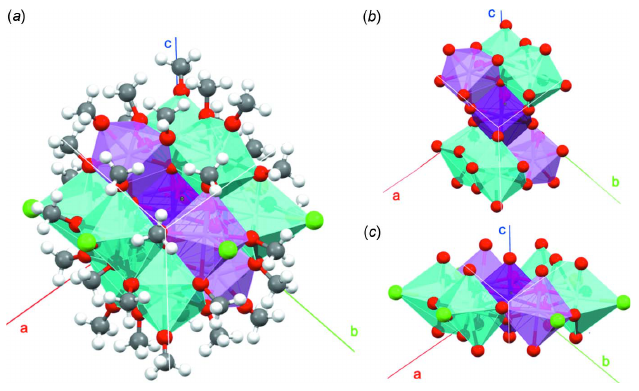
Figure 2 Molecular structure of the {U 13 } cluster I . Uranium atoms are illustrated with coloured polyhedra. The structure is drawn as [U 13 ( (cid:2) 4 -O oxo ) 8 - Cl 6 (MeO) 32 ] in order to omit the disorder between chloride and methoxide anions for clarity. Colour code: hydrogen, white; carbon, black; oxygen, red; chlorine, light green. Hydrogen and carbon atoms are also omitted for clarity in ( b ) and ( c ).